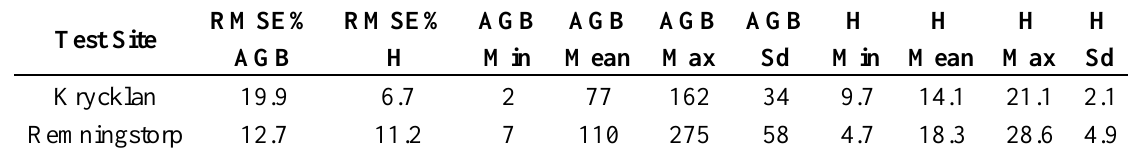
Table 1. Properties for the derived reference rasters with AGB in tons·ha −1 and H in m.